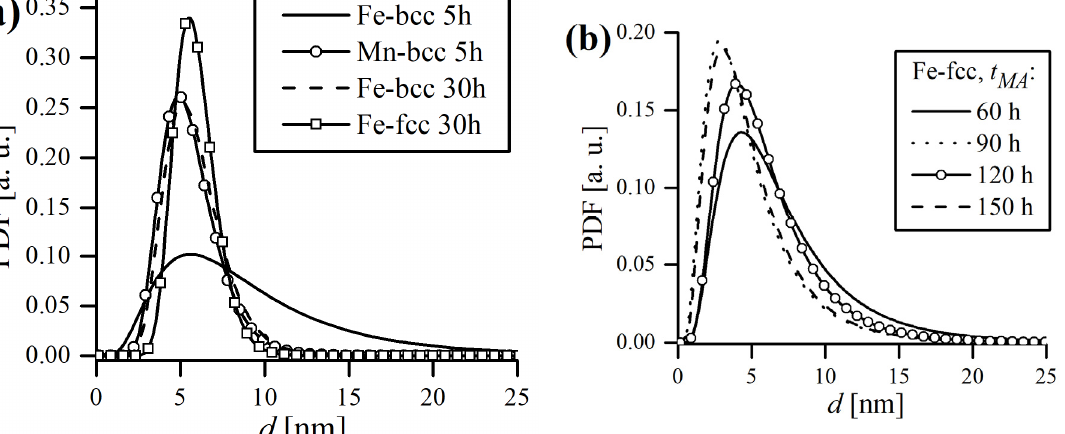
Figure 10. Lognormal domain size distributions of crystalline domains: ( a ) up to 30 h of MA, ( b ) after 30 h of MA, in terms of probability density function (PDF).